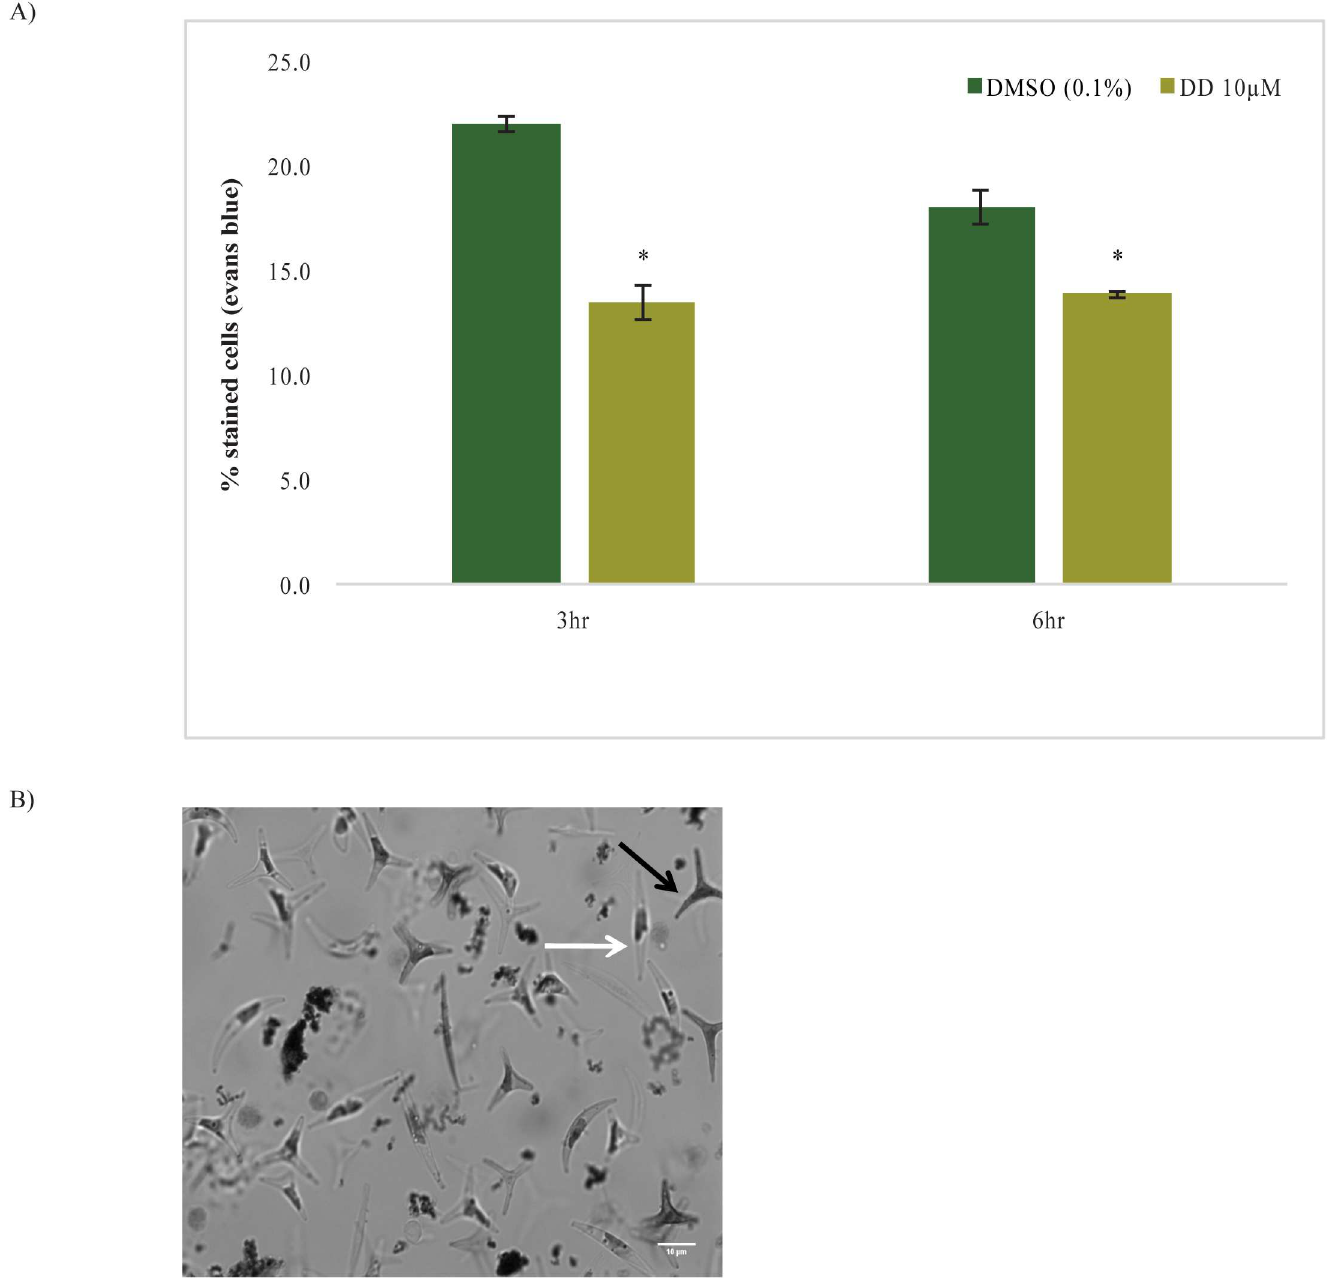
Fig 5. Effects of DD on Evans Blue staining. A) Analysis of % stainedcells by cell counting on hemocytometer B) Bright field image (630X) of cells stained with Evans Blue dye (scale bar = 10 µ m). p < 0.05 calculatedusing student’s t-test; n = 3 comparedto solvent control. Data are representative of 3